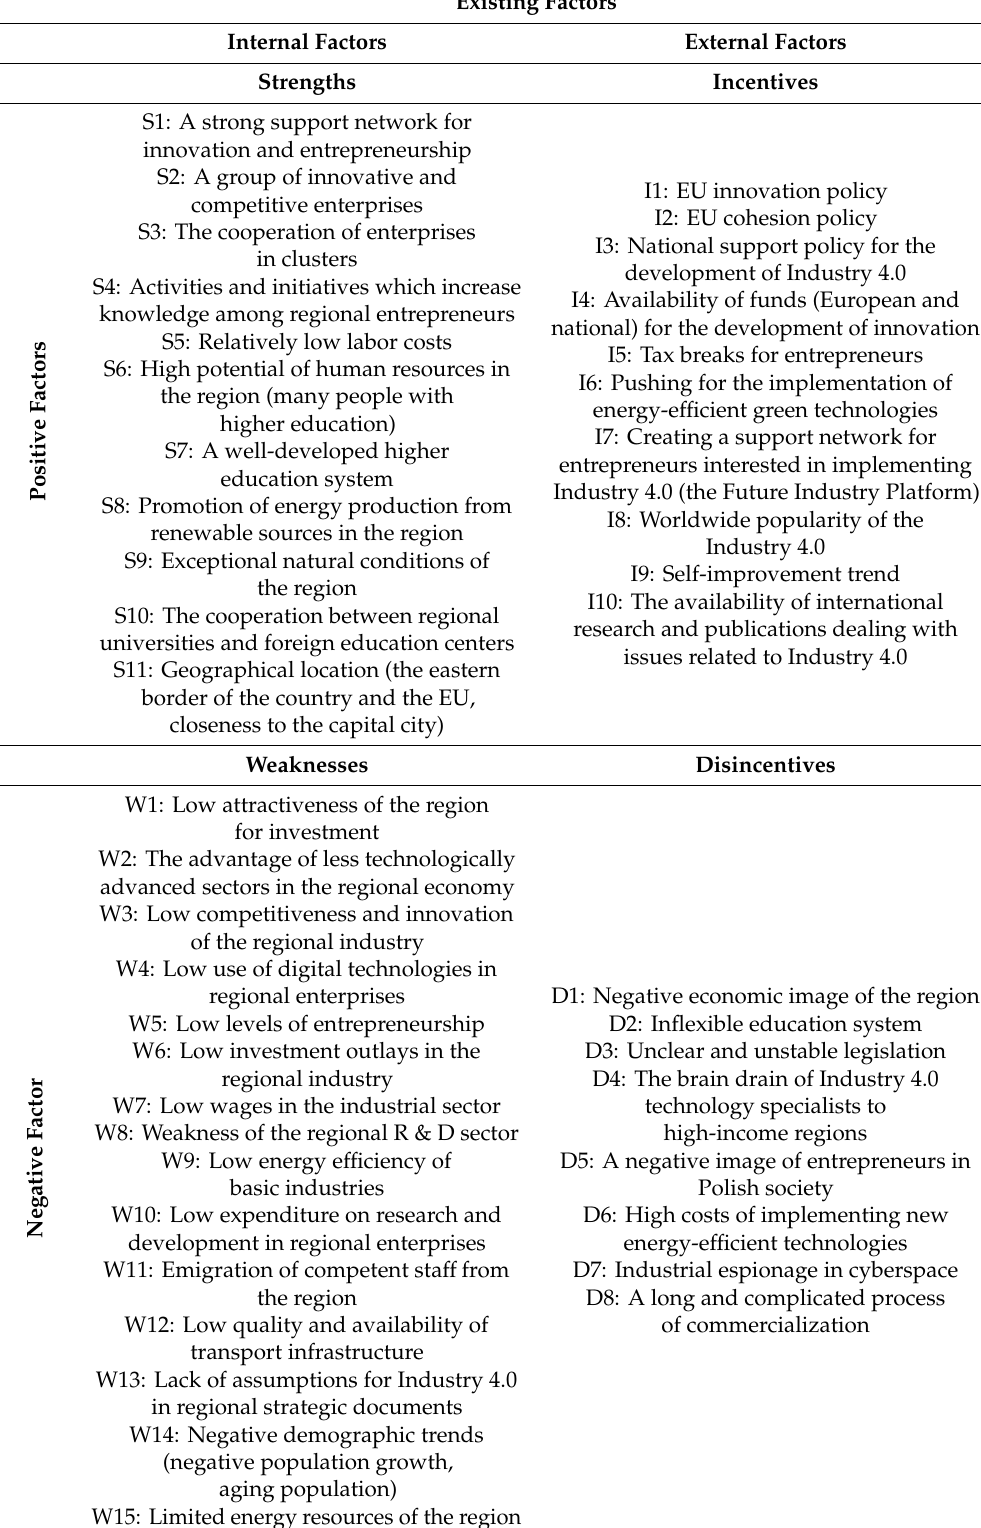
Table 4. SWOT analysis of Podlaskie Voivodeship in the context of the development of Industry 4.0 (existing